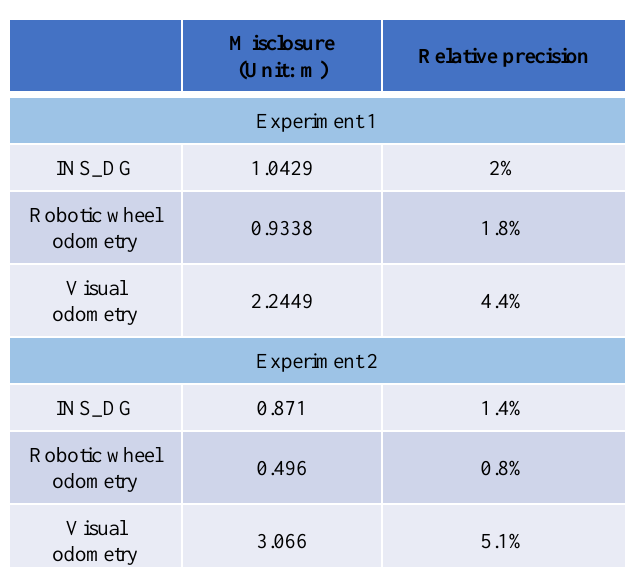
Figure 7. The comparison between indoor positioning solutions and ground truth in experiment 2